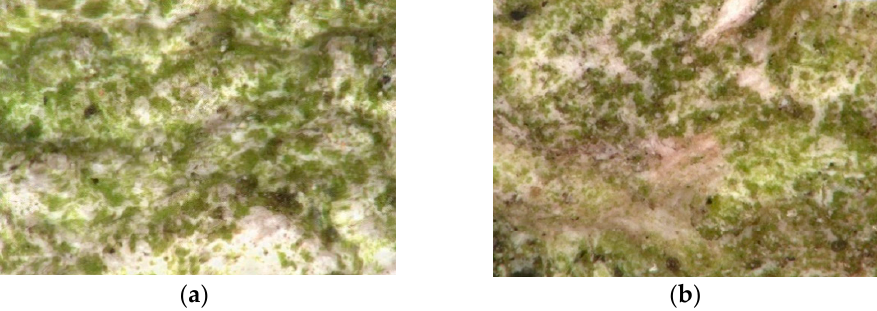
Figure 2. The surface of the ( a ) northern mineral-based dashed plaster—200× magnification photo taken with KEYENCE digital microscope (VHX-7000); ( b ) northern mineral-based filled plaster— 200× magnification photo taken with KEYENCE digital microscope (VHX-7000).